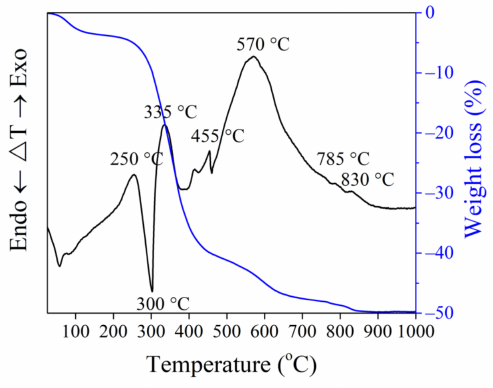
Figure 4. Thermal analysis of OCW up to 1000 ◦